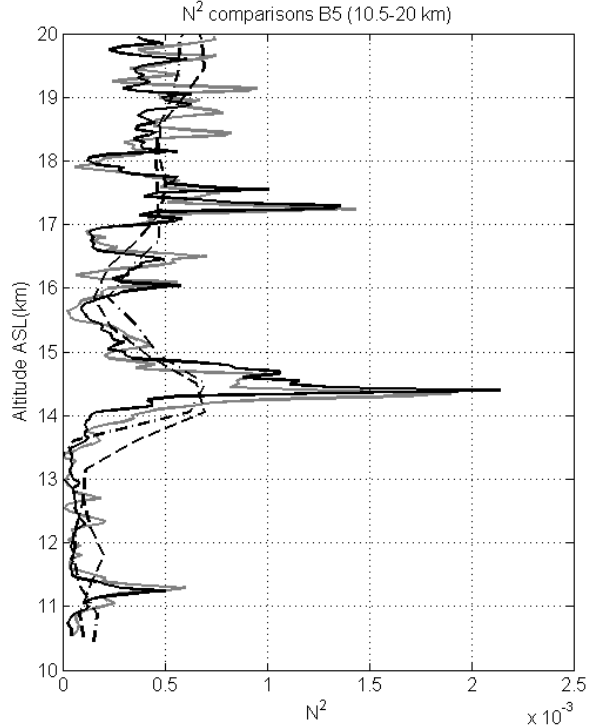
Fig. 6c. Same as Fig. 6a but for B5.